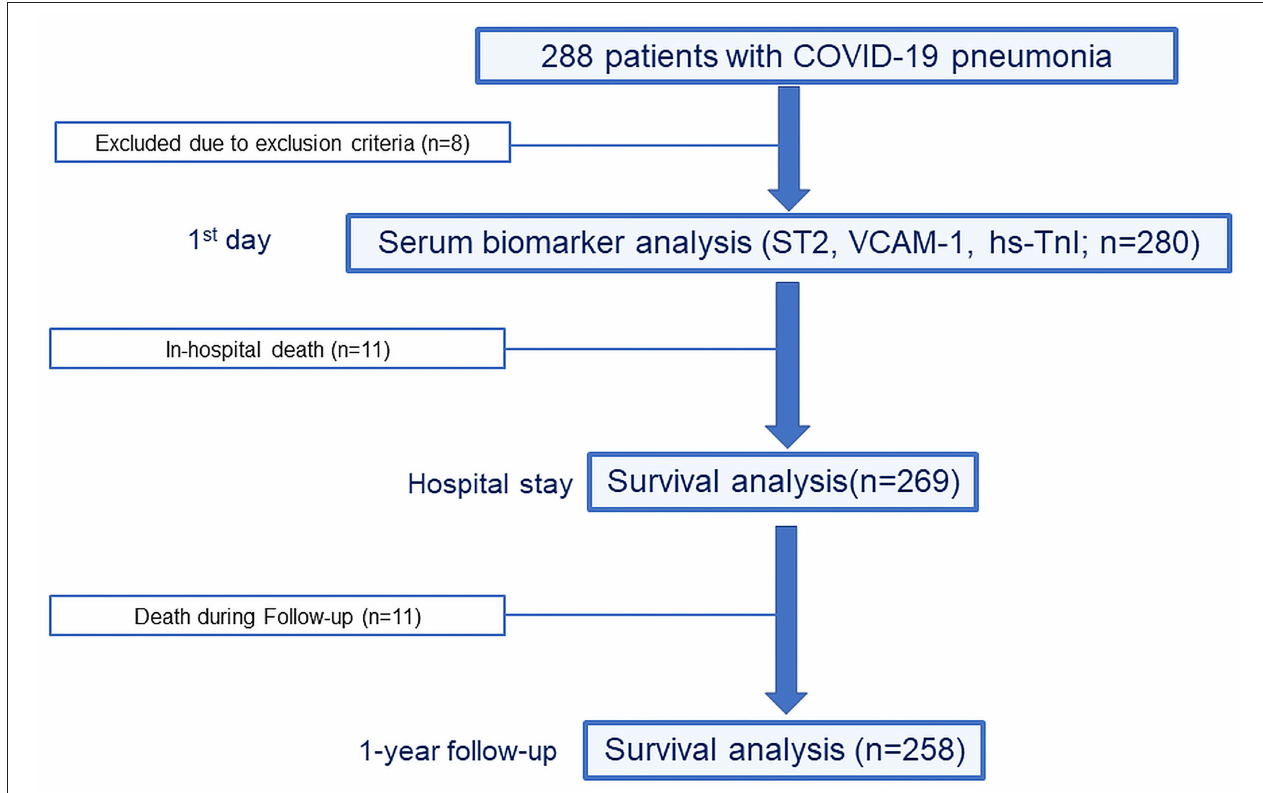
FIGURE 1 | Design of the